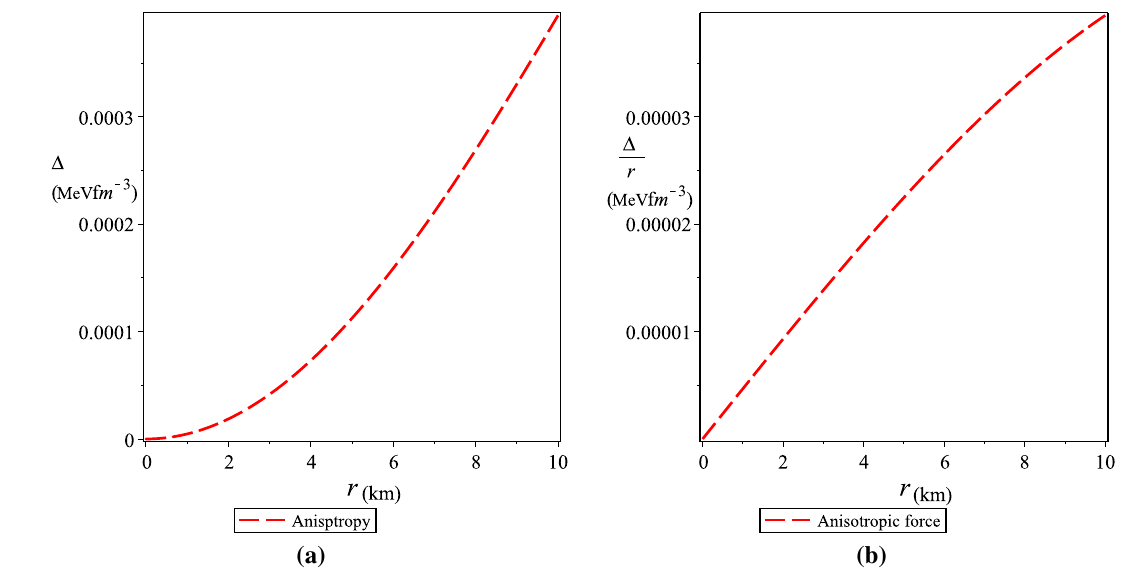
Fig. 3 Plots of the anisotropy and anisotropic forces for solution (26) vs the radial coordinate r in Km using PSR J 1614-2230 constraints